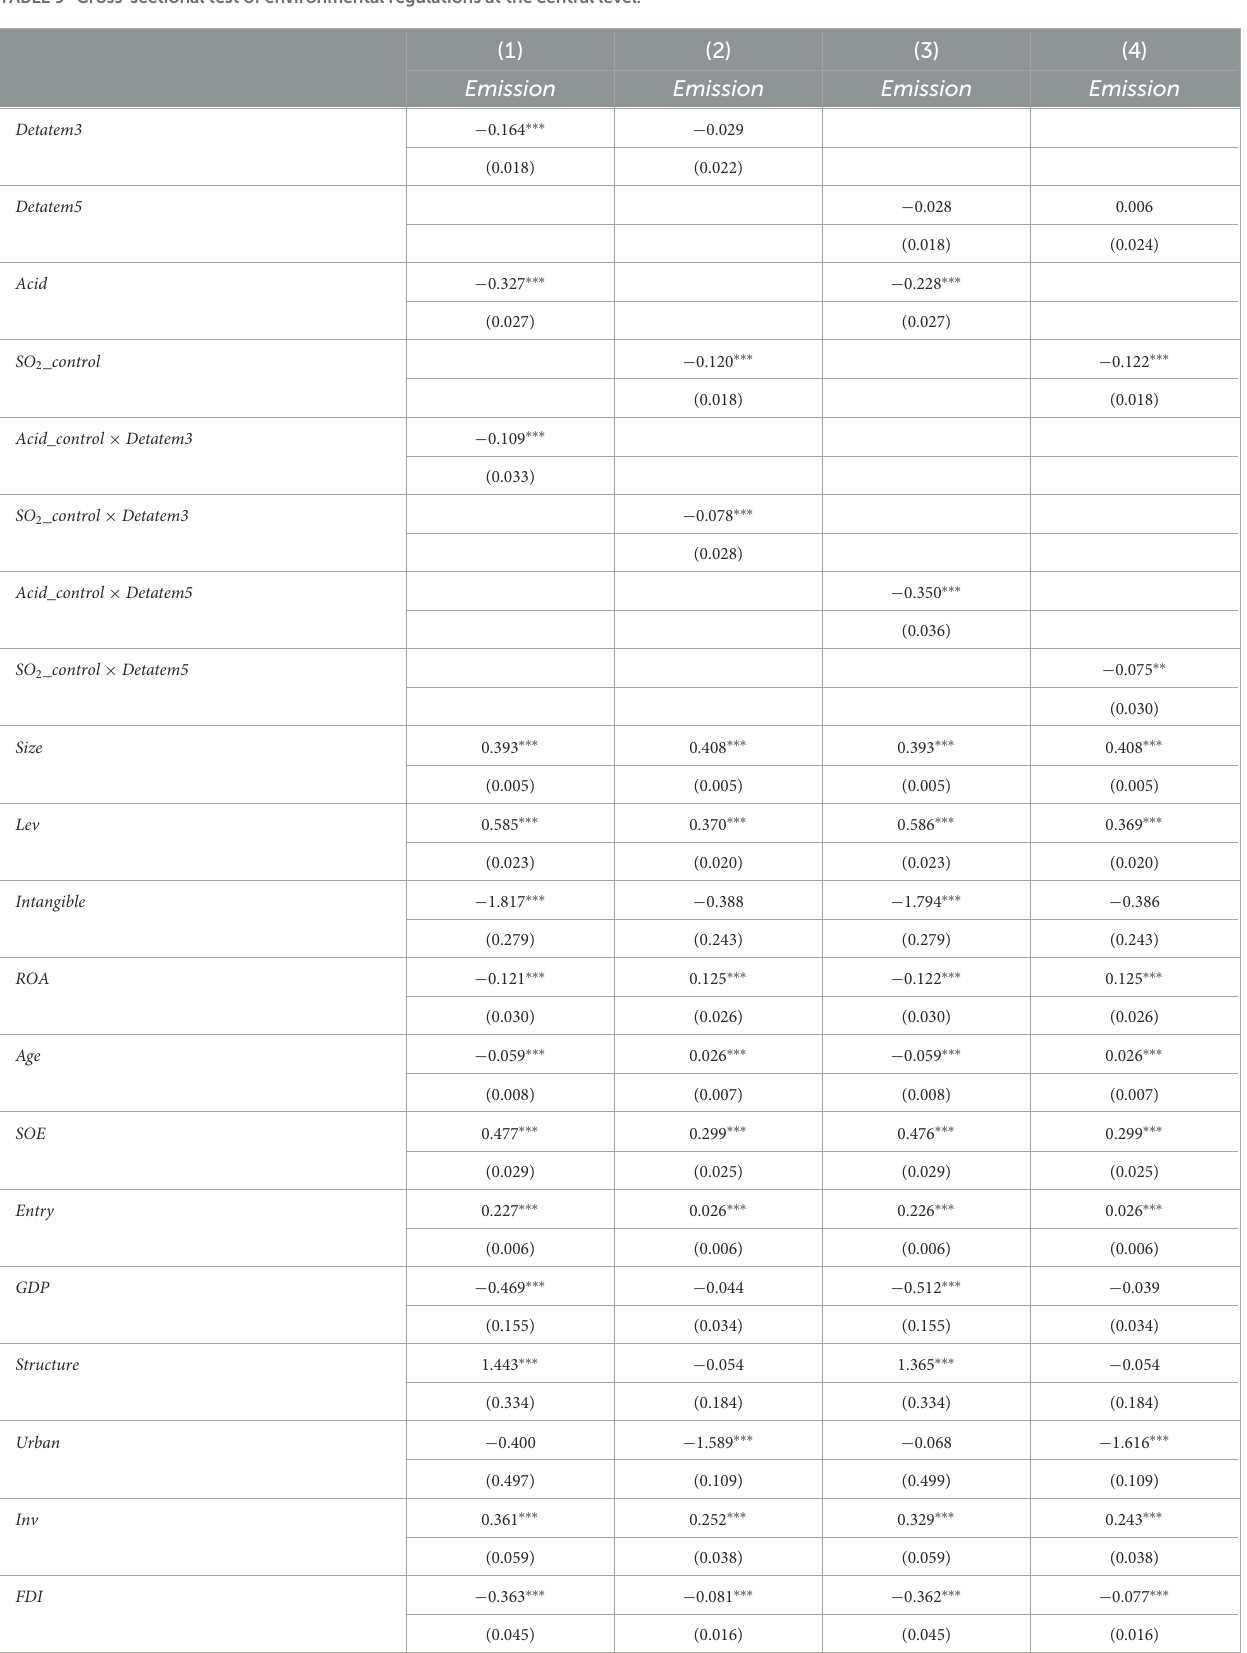
TABLE 9 Cross-sectional test of environmental regulations at the central